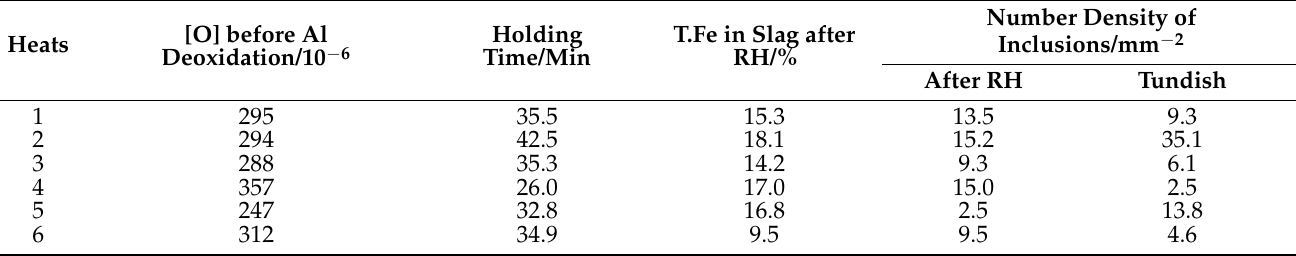
Table 3. Parameters of experimental heats during RH and tundish